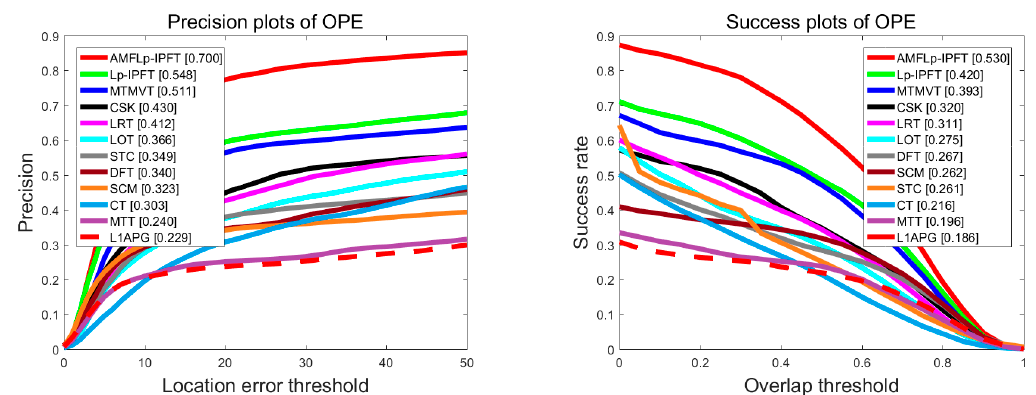
Figure 4. Comparisons of different trackers by using precision and success plots over all 50 sequences. The legend contains the ACU score for each tracker. Table 2. Quantitative comparison of 12 trackers on 50 sequences.